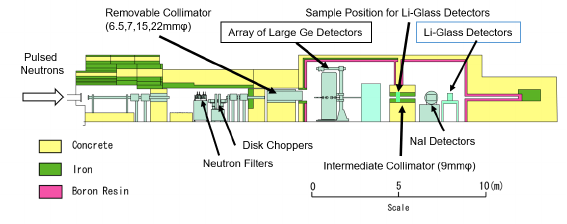
Figure 1. Vertical cross-sectional view of